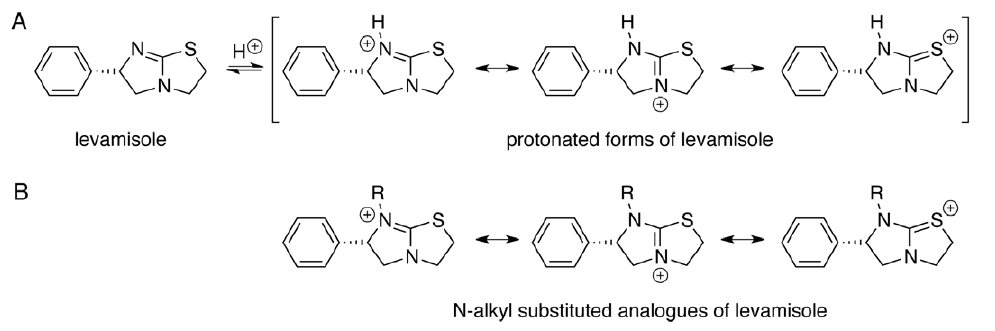
Figure 1. Generic structures of compounds studied. A) Levamisole and resonance forms of protonated levamisole; B) resonance forms of N- substituted analogues of levamisole.